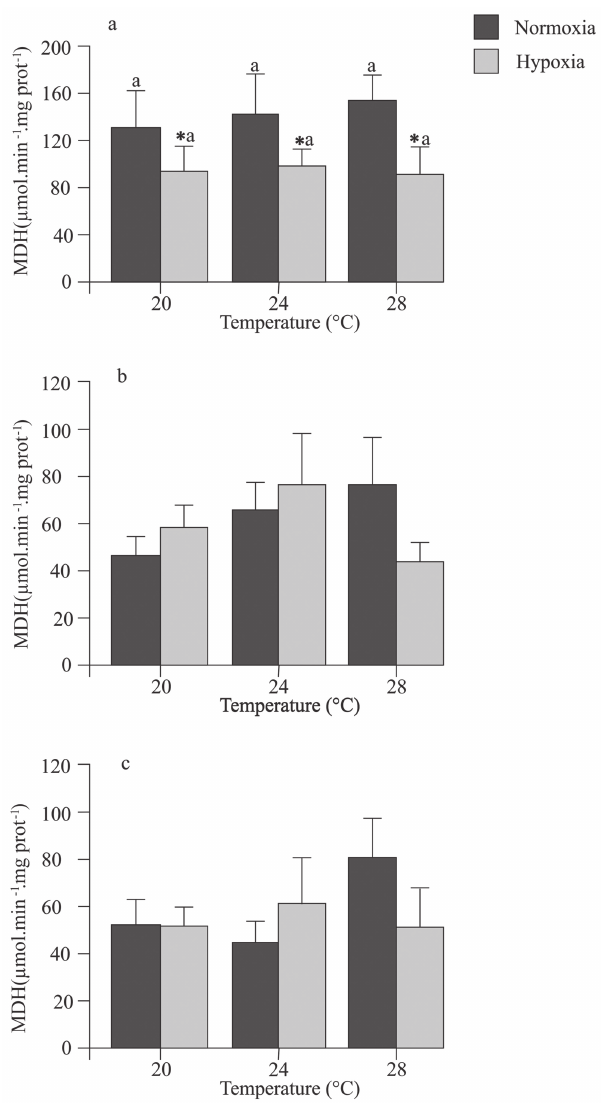
Fig. 1. Malate Dehydrogenase enzyme activity of Geophagus brasiliensis exposed to normoxic (90% oxygen saturation) and hypoxia (20% oxygen saturation) conditions for 8 hours at 20°C, 24°C and 28°C. a. in liver; b. in white muscle; and c. in heart. Asterisks indicates significant differences between treatments at the same temperature, p < 0.05. Different lowercase letters indicate significant differences for the same treatment at the temperatures studied, p < 0.05.